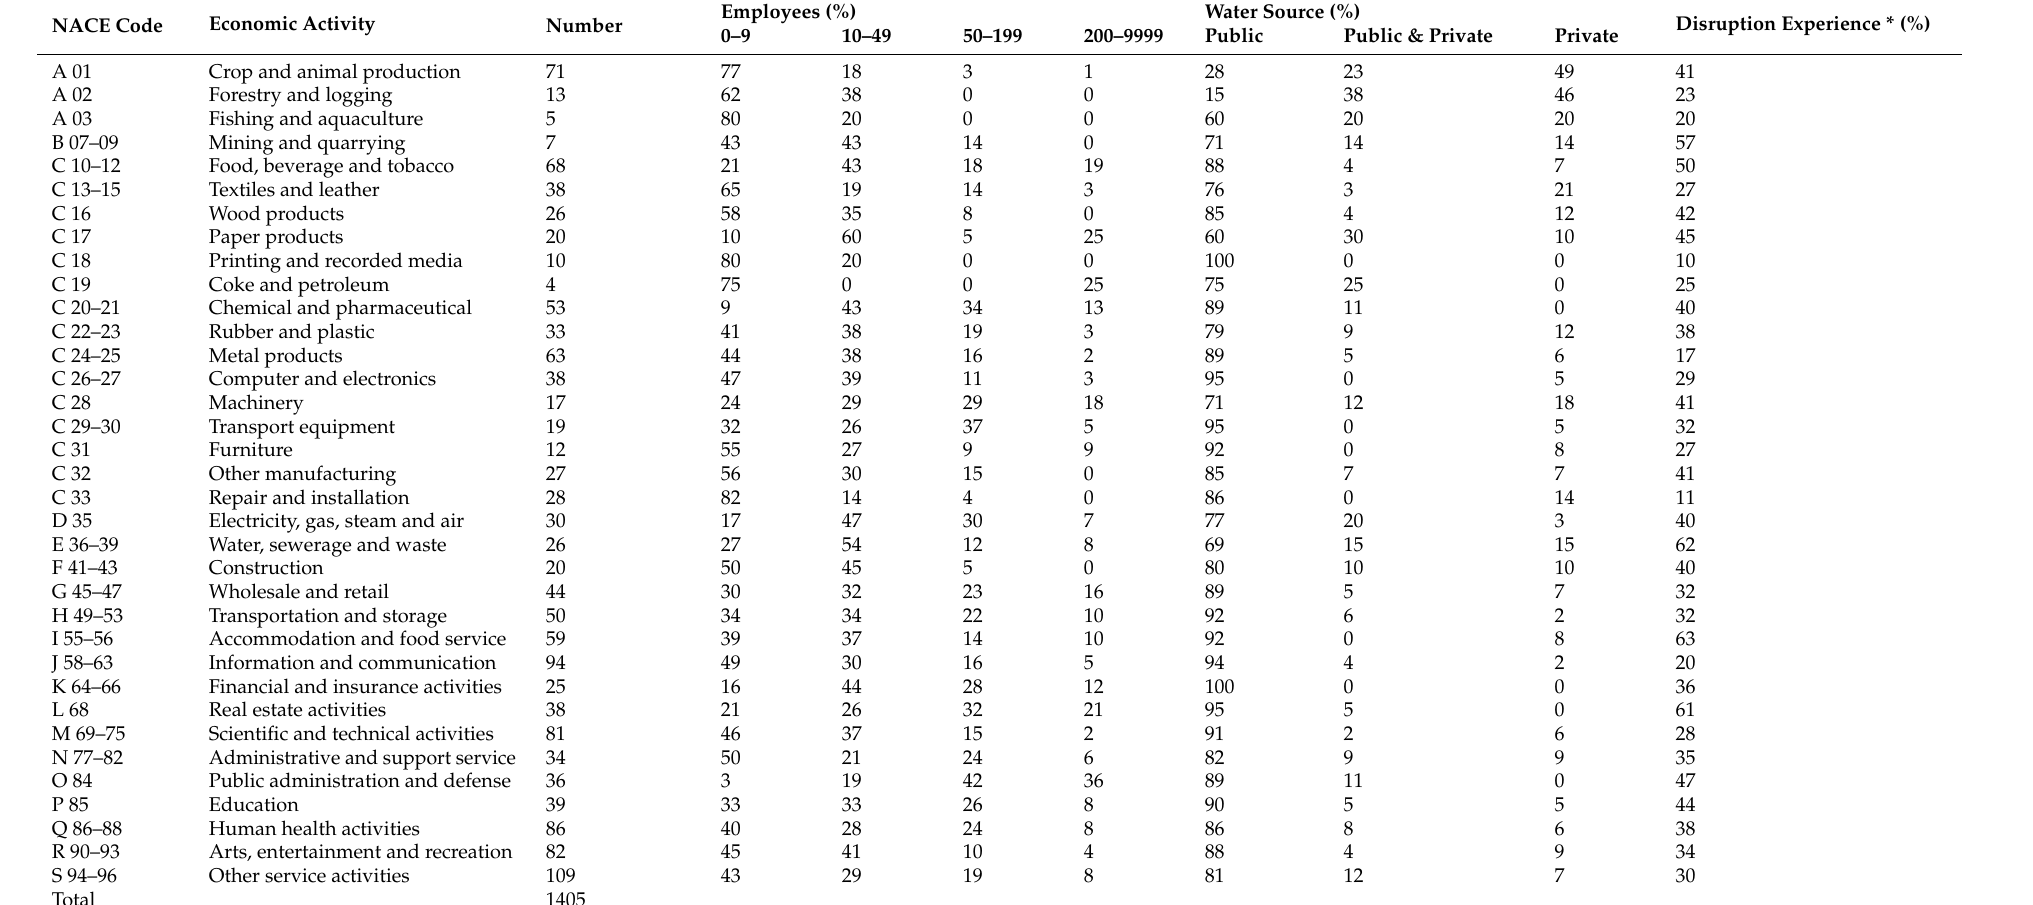
Table 1. Descriptive statistics of responding